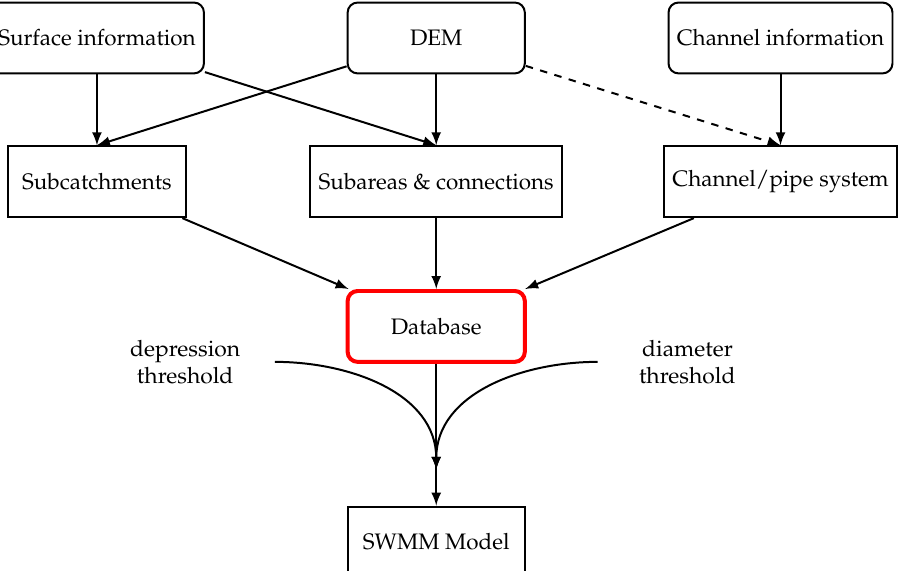
Figure 2. Schematic overview of data processing for efficient 1D1D